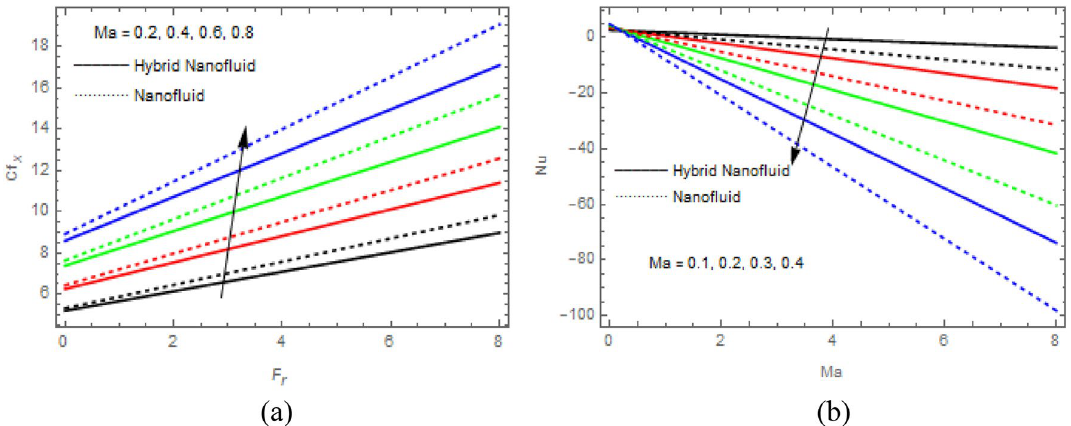
Figure 19. ( a , b ) Influence of Ma on Cf x and Nu .